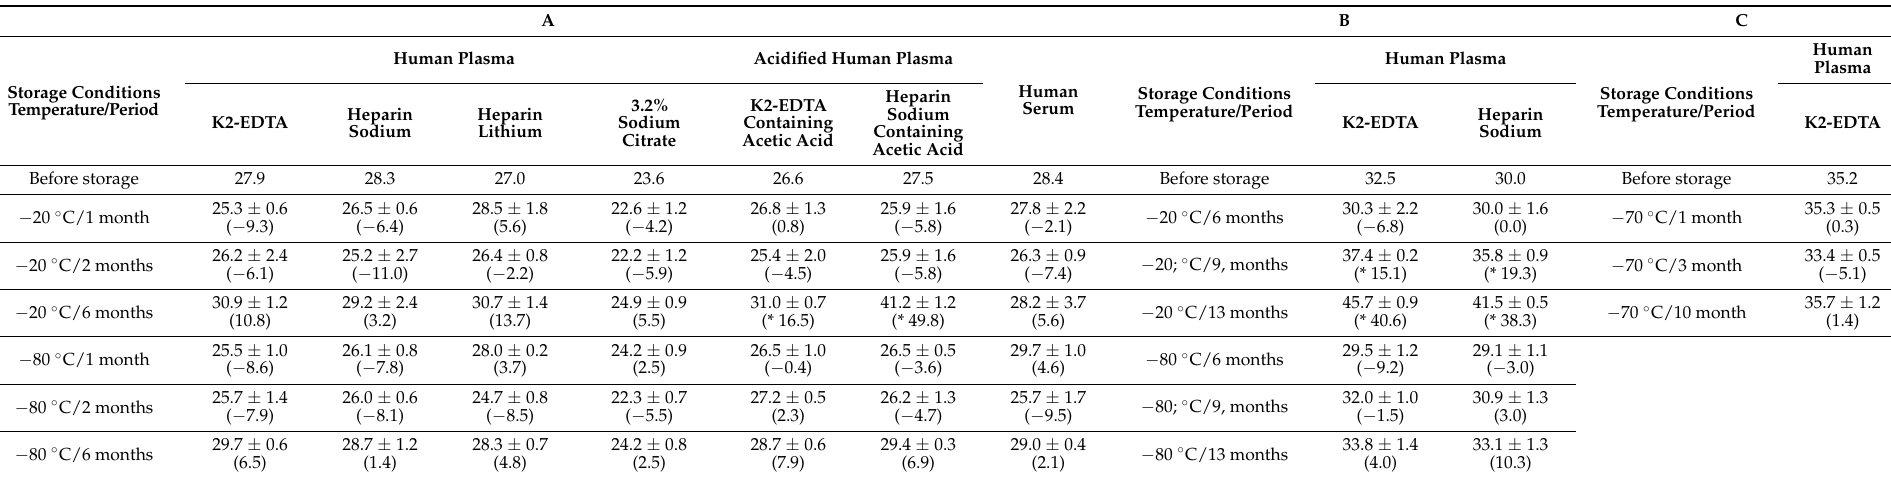
Table 1. Long-term storage stability test of human plasma, serum, and acidified plasma. A B